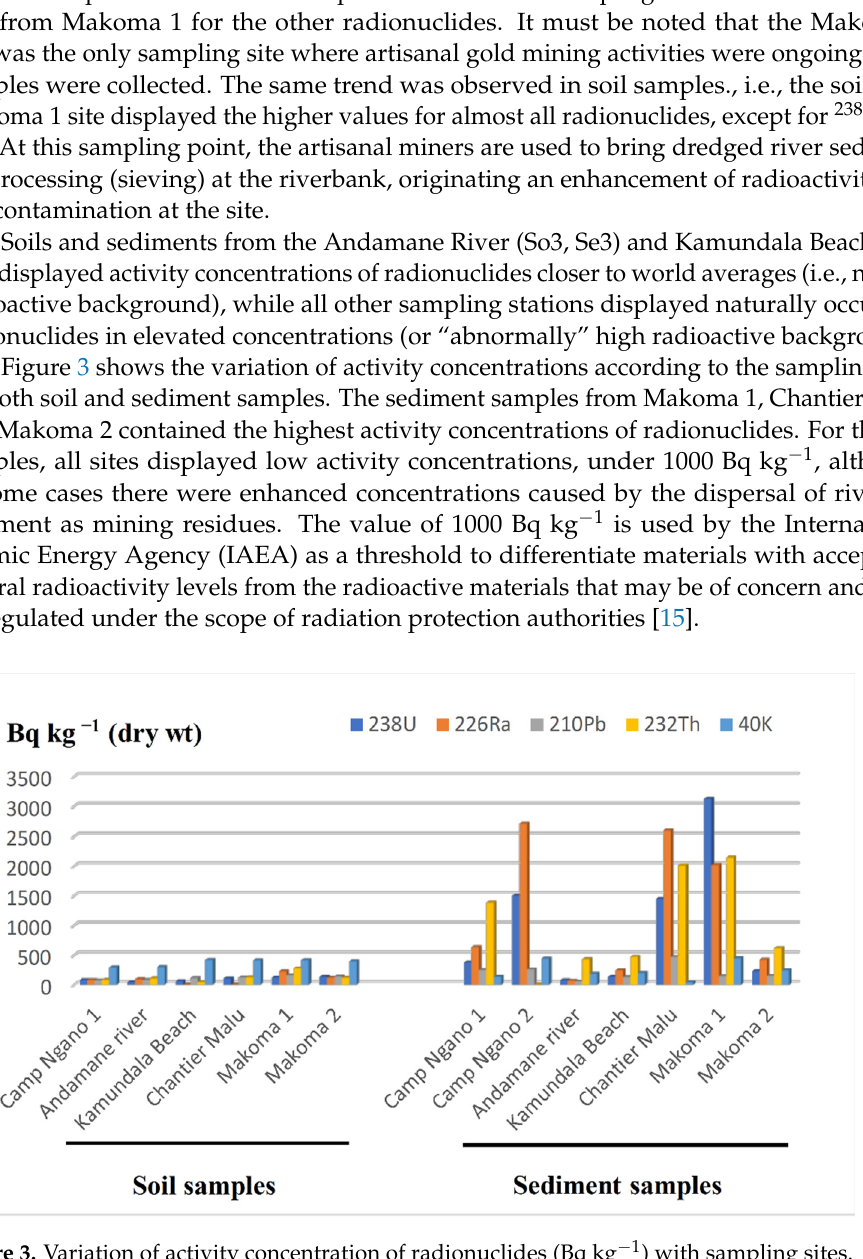
Table 3. Comparison of the average activity concentrations (Bq kg − 1 ) of 238 U, 232 Th, 226 Ra, and 40 K from Ulindi River region with reported concentrations from other regions and from other countries.